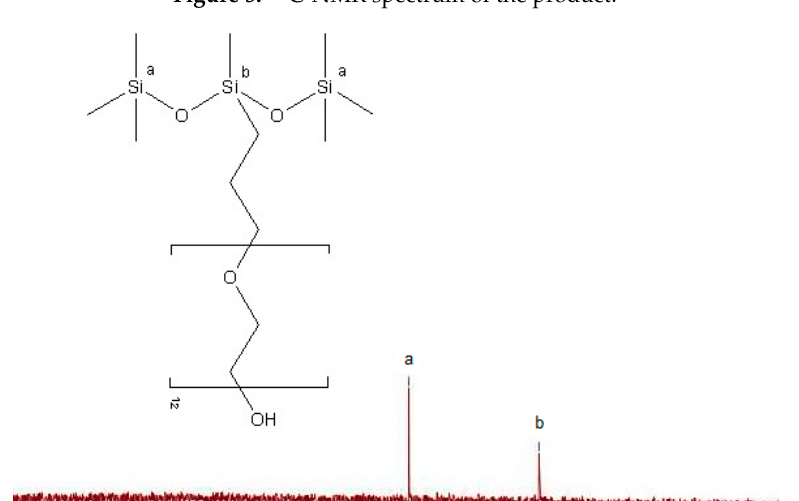
Molecules 2020 , 25 , x